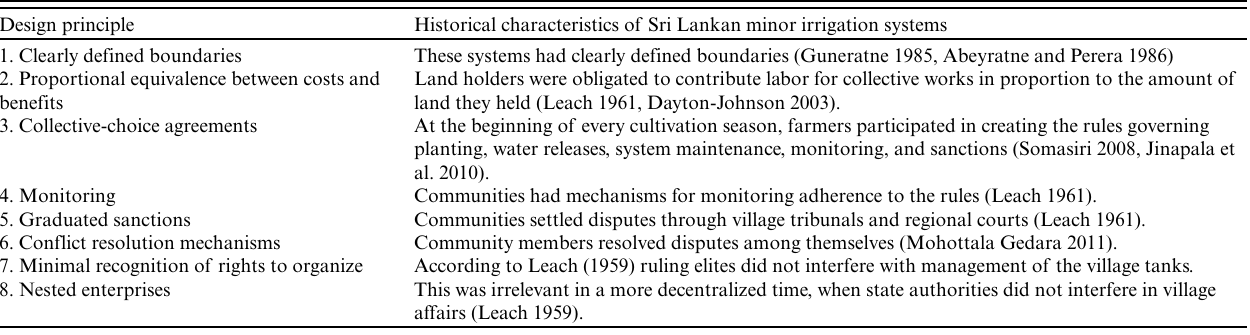
Table 1 . Applicability of Ostrom’s (1990, 1993) design principles to historic patterns in Sri Lankan minor irrigation systems.